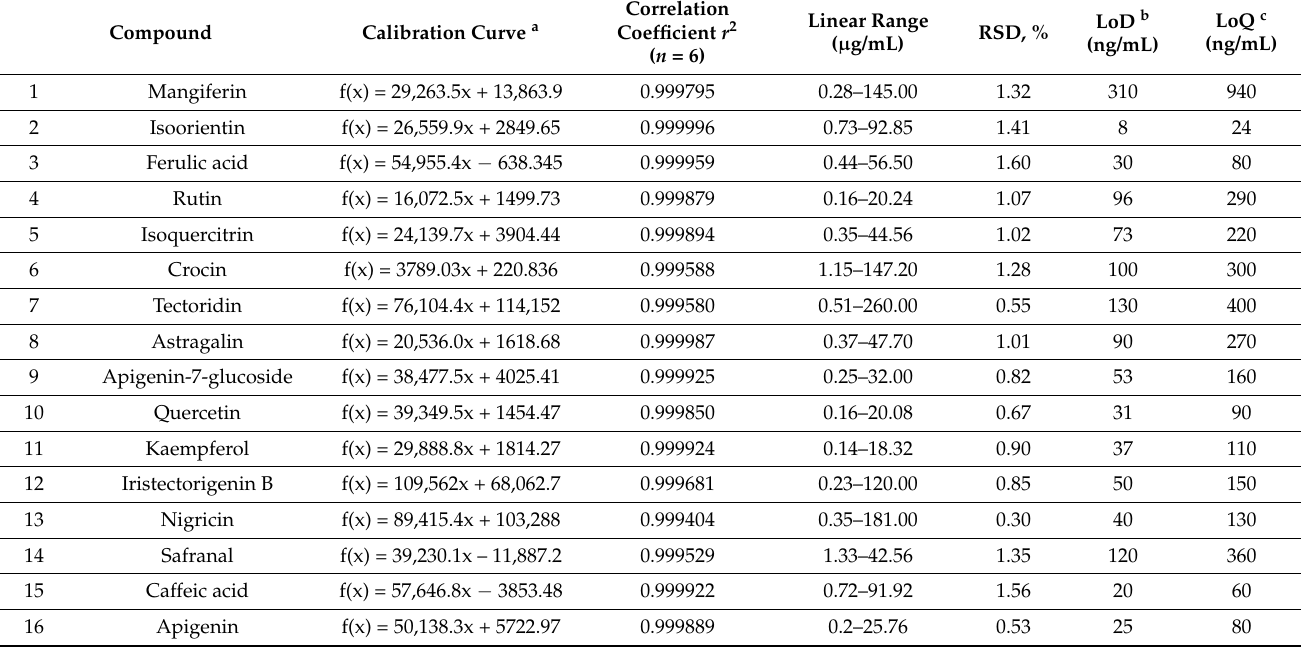
Table 3. Calibration curves of the reference standard